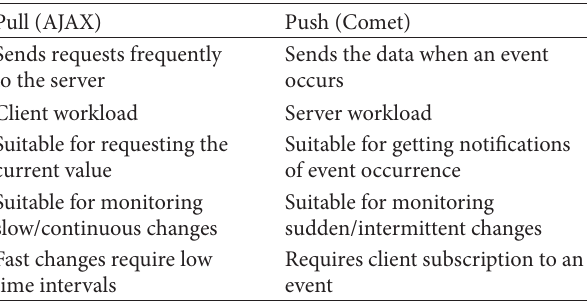
Table 1: A comparison between pull model and push model for requests and data